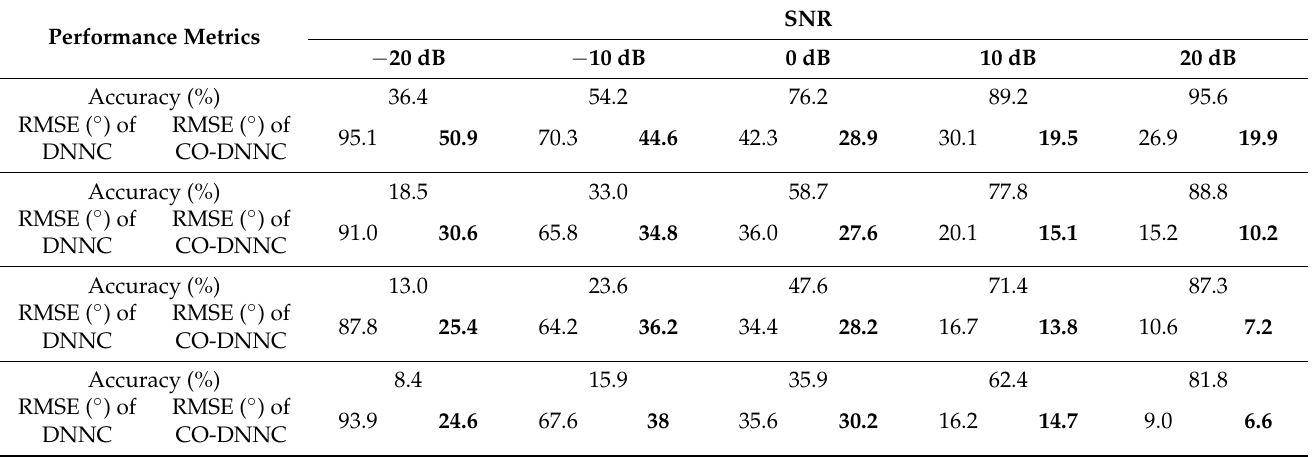
Table 2. Accuracies of DNNC and RMSEs of CO-DNNC and DNNC with varied SNRs and classes